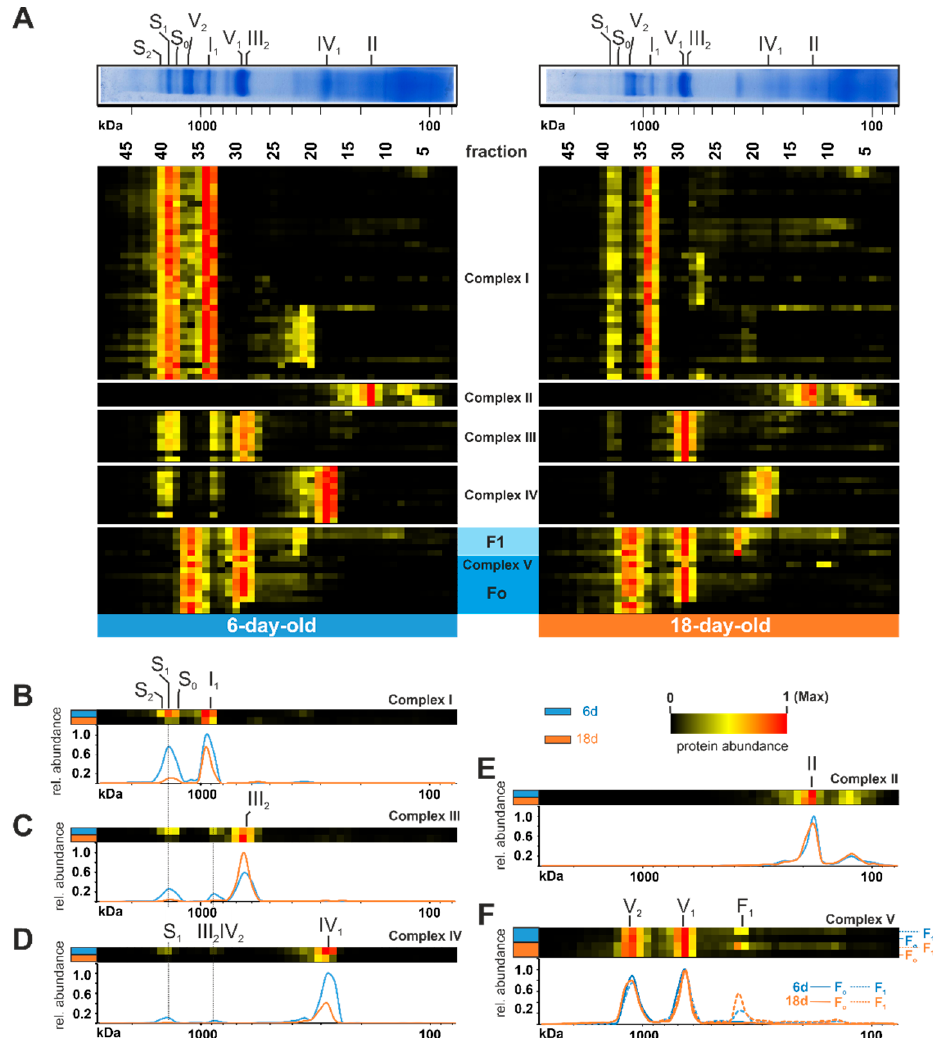
Figure 2. Age-dependent changes of respiratory chain complexes. ( A ) Identified subunits of all complexes of the oxidative phosphorylation system are represented in a heat map. The relative abundances were normalized to the maximum value within each lane. The color scale ranges from black (not identified), to yellow (20% of the maximum in ( A ), 15% in ( B – F )), to red (maximum abundance). For detailed information about the corresponding proteins refer to Table S1C. Heatmaps of a combination of all respiratory chain complexes and visualization in 2D profiles for ( B ) complex I, ( C ) complex III ( D ) complex IV, and ( E ) complex II. ( F ) Complex V (ATP synthase) with the appearance of F 1 and F o